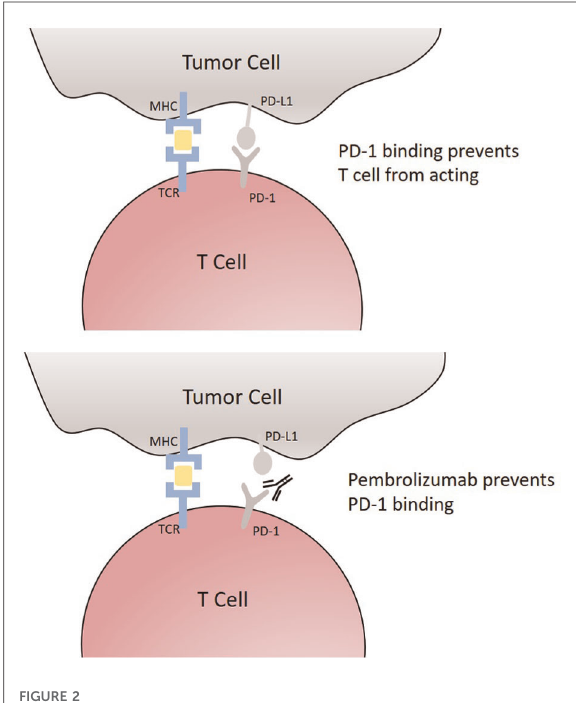
FIGURE 2 Pembrolizumab mechanism of action. Pembrolizumab prevents PD- 1 binding and blocking T-cell and tumor cell interaction, allowing for immune-mediated tumor cell